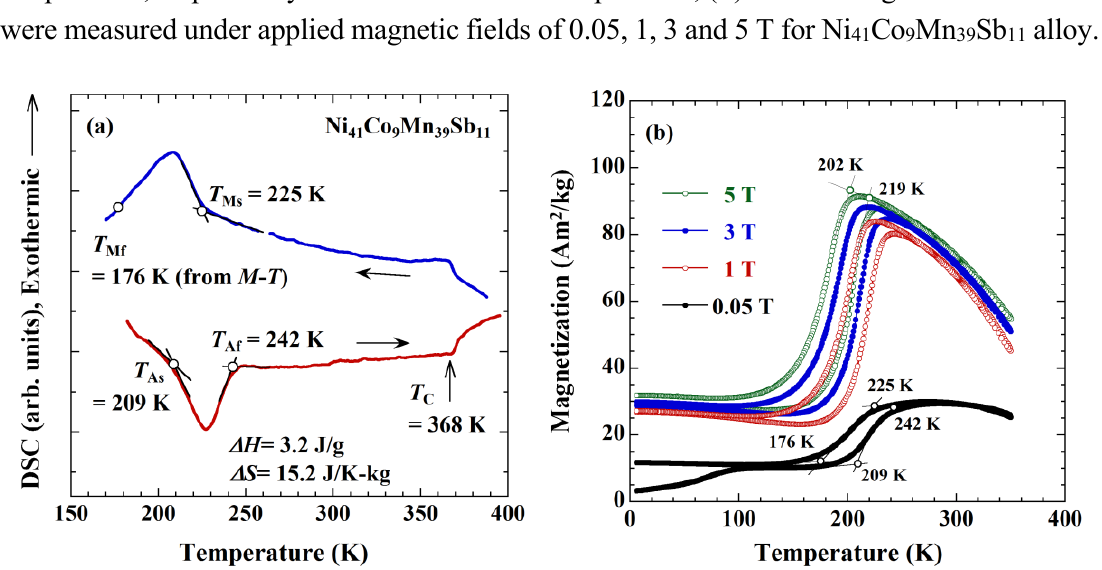
Figure 2. ( a ) DSC heating and cooling curves measured at a rate of 10 K/min for Ni 41 Co 9 Mn 39 Sb 11 alloy. T Ms , T Mf , T As and T Af are martensitic transformation starting temperature, finishing temperature, and reverse martensitic transformation starting temperature and finishing temperature, respectively. T C means the Curie temperature; ( b ) Thermomagnetization